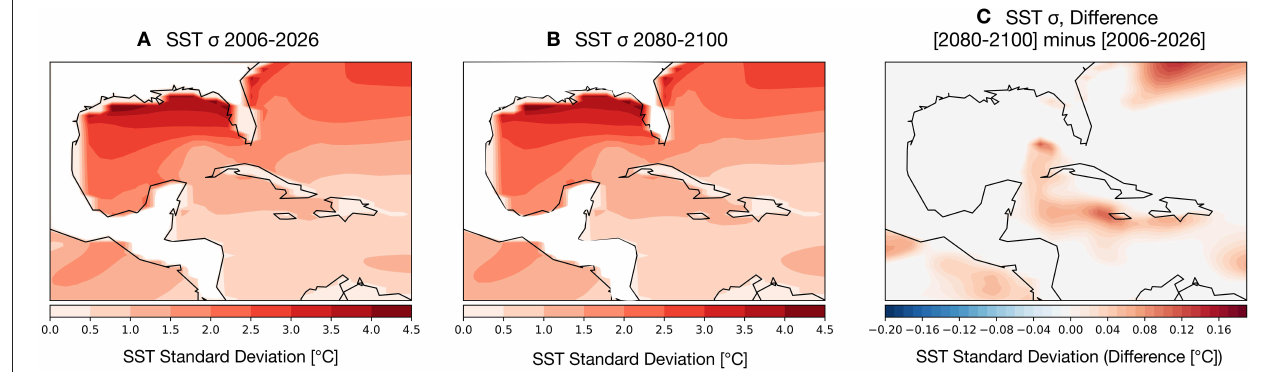
FIGURE 5 | Simulated changes in the standard deviation (1- σ ) of GoM SST [ ◦ C] in the RCP8.5 Large Ensemble, CESM1.2. (A) 2006–2026 SST σ . (B) 2080–2100 SST σ . (C) (2080–2100 mean σ minus 2006–2026 mean σ ). Continental regions are outlined in black